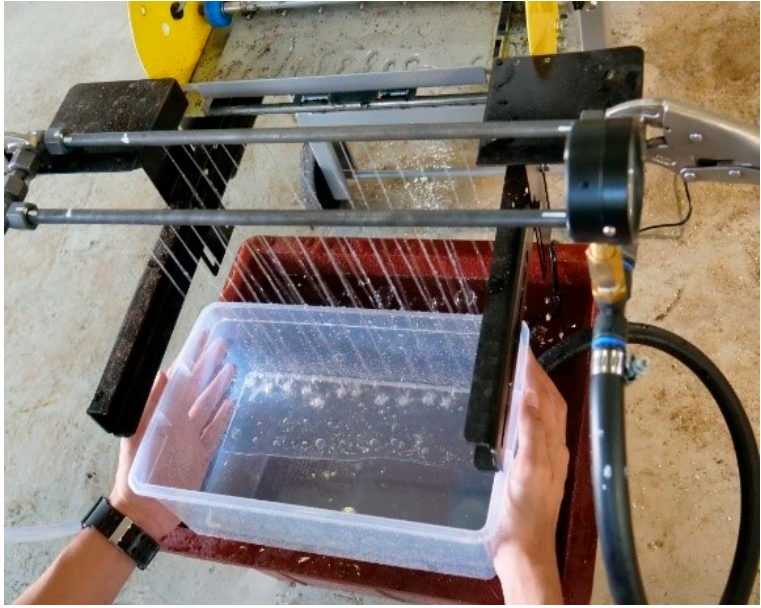
Figure 9. Measurement of flow rate of each irrigation pipe.